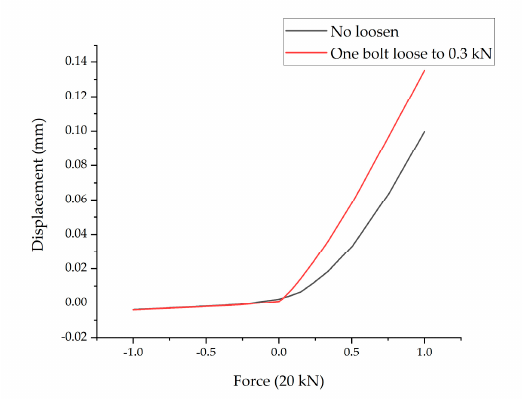
Figure 10. Force-displacement curve (static loads).